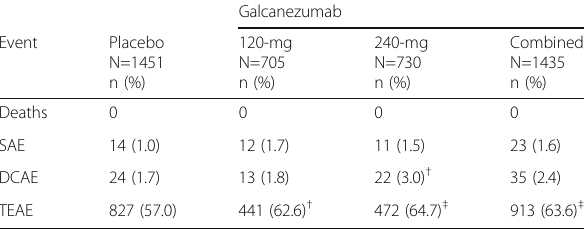
Table 2 (abstract P70). Overview of adverse events.